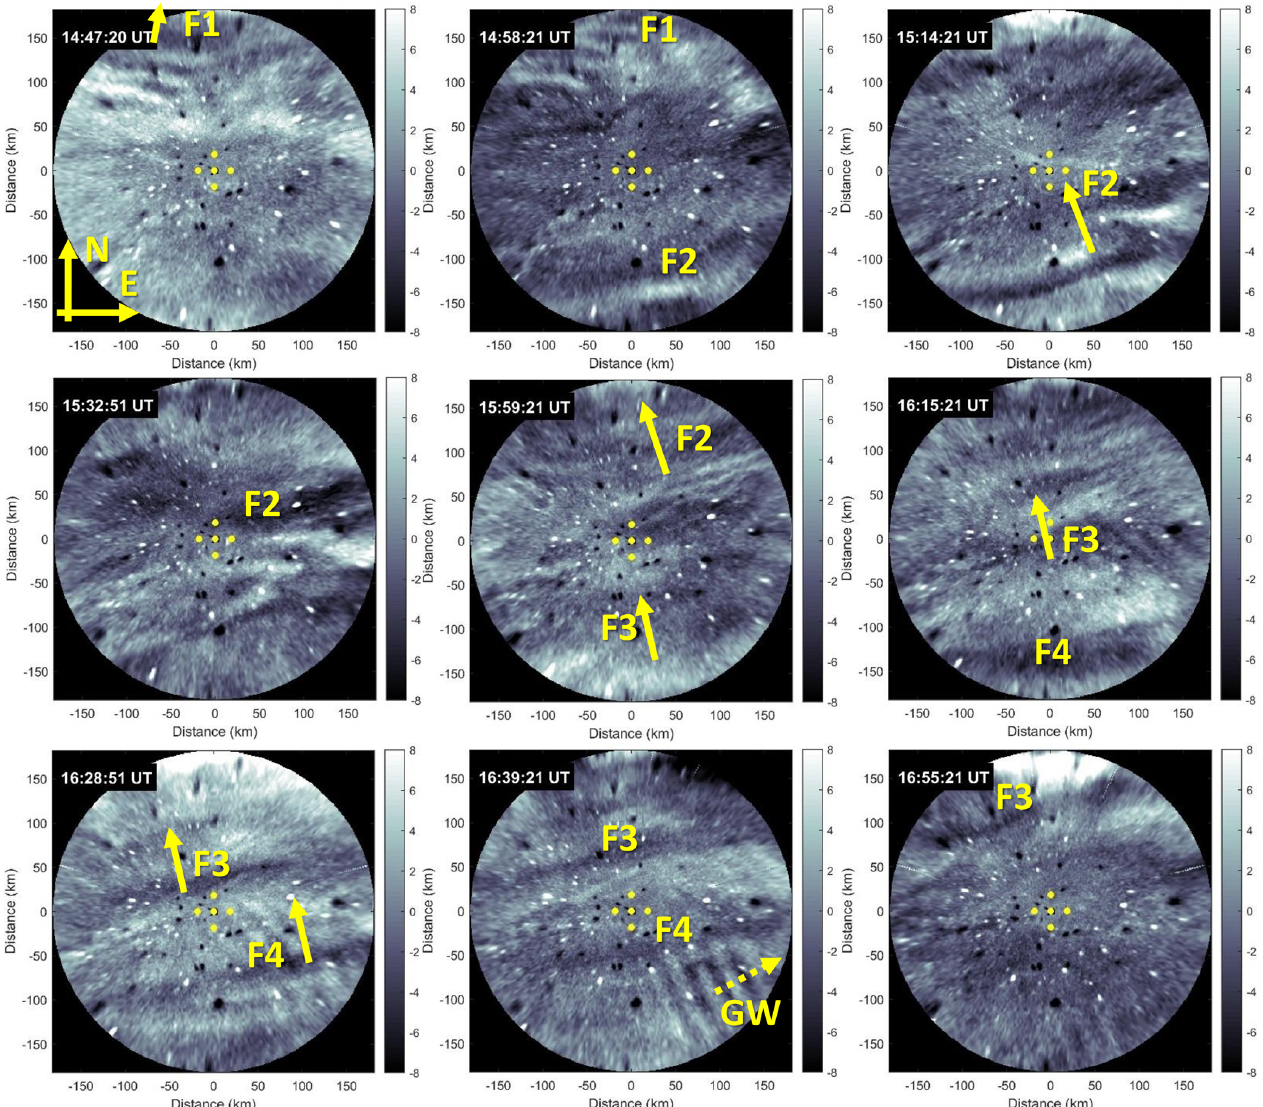
Figure 4. Selected OH airglow images from 19 December 2014. Intensities represent the percentage perturbations according to Eq. (3). The yellow dots near the zenith indicate the location of the lidar beams. The fronts are marked as F and their propagation direction is indicated by an arrow. The gravity wave is indicated as GW with a dashed